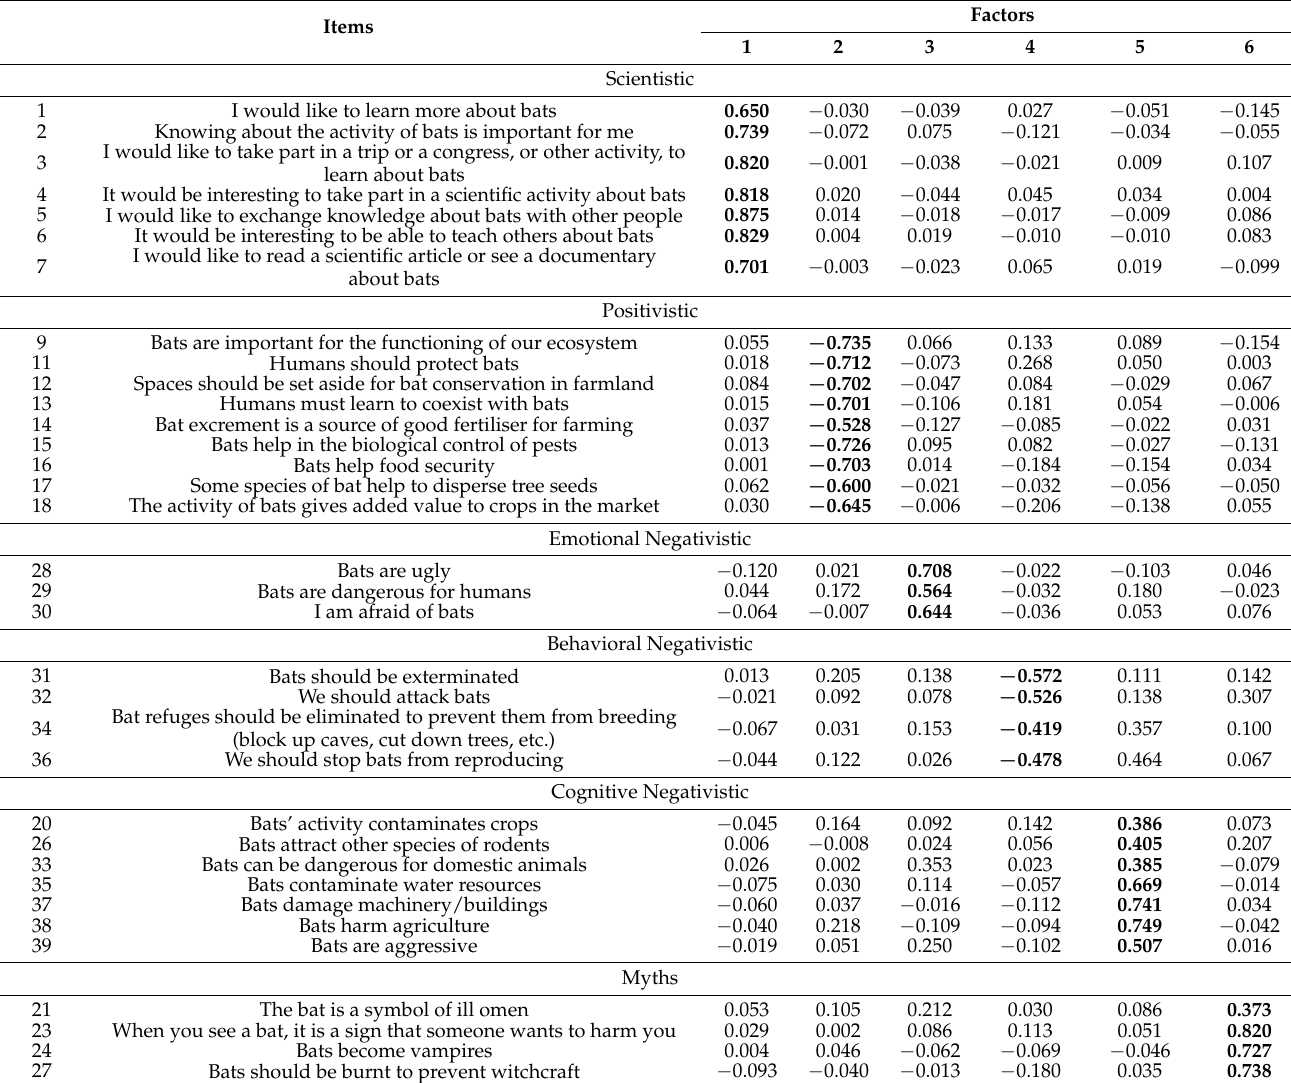
Table 2. The exploratory factor analysis (EFA) results in Group 1 sample (N = 820). Extraction of unweighted least squares and oblimin oblique rotation.